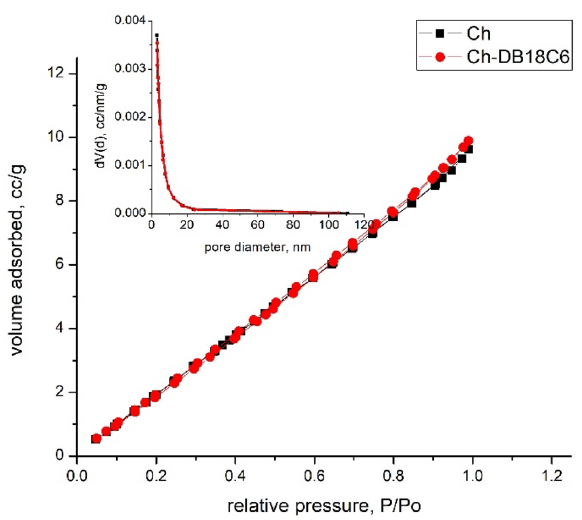
Figure 4. Adsorption